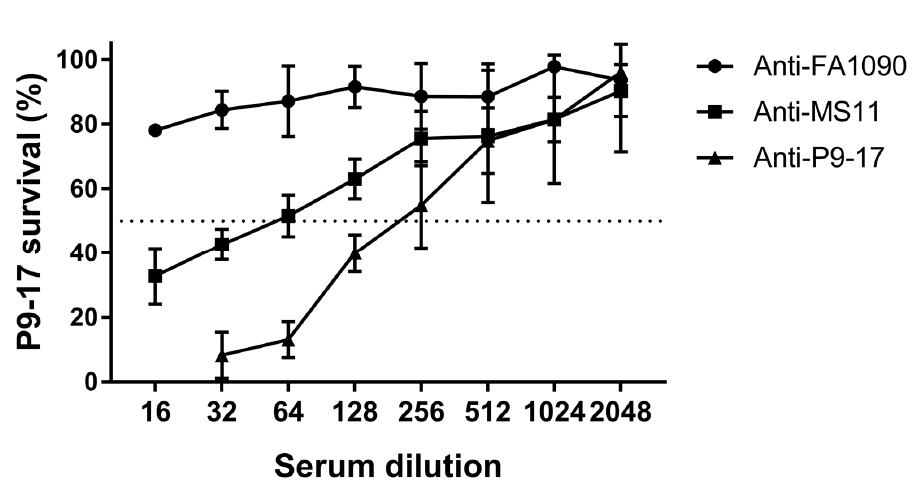
Figure 5. Measurement of cross-reactive SBA to N. gonorrhoeae P9-17 by detection of ATP. Serial twofold dilutions of murine sera raised to OMV extracts from N. gonorrhoeae P9-17, FA1090 or MS11 were incubated with N. gonorrhoeae P9-17 and bacterial survival measured by ATP (luminescence). Data are combined means ± SD from three independent experiments.